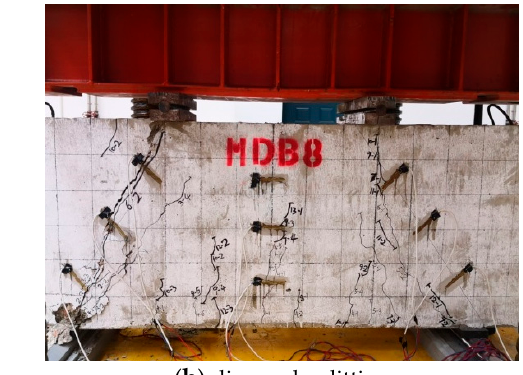
Figure 8. Relation curve between λ and deflection.